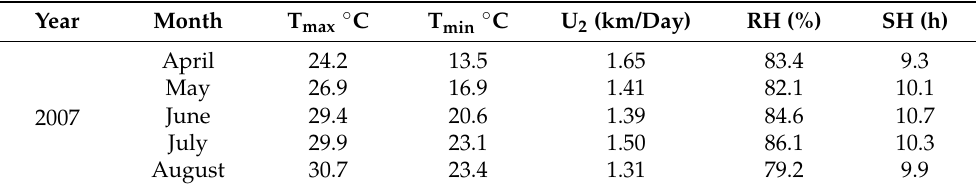
Table 1. Agro-climatological data for the study area recorded at Borg Alarab Station (latitude of 31.2 ◦ and longitude of 29.916 ◦ ). This data is just from the period of our